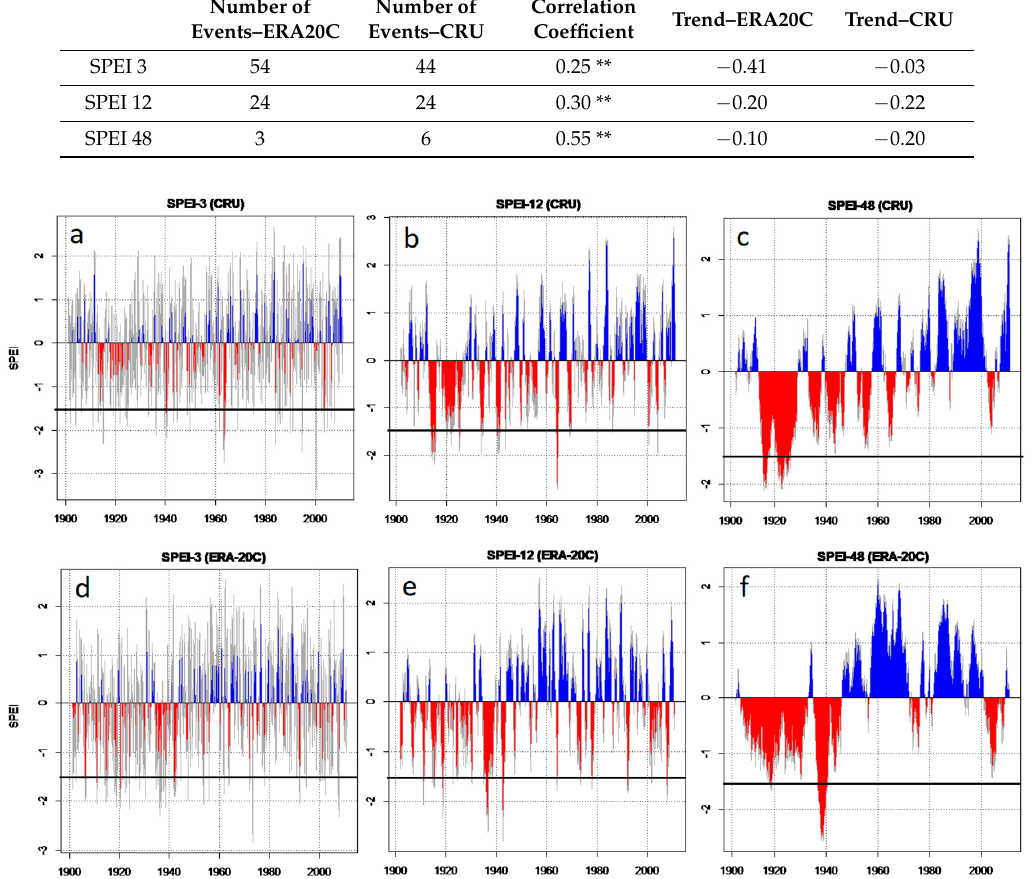
Figure 5. SPEI for 3-( a , d ), 12-( b , e ) and 48-month ( c , f ) timescales on the ESP region. ( a – c ) CRU data (1901–2010); ( d – f ) ERA20C reanalysis (1901–2010). Red (blue) regions in the graph represent negative (positive) SPEI values. The solid line marks the threshold SPEI = − 1.5.